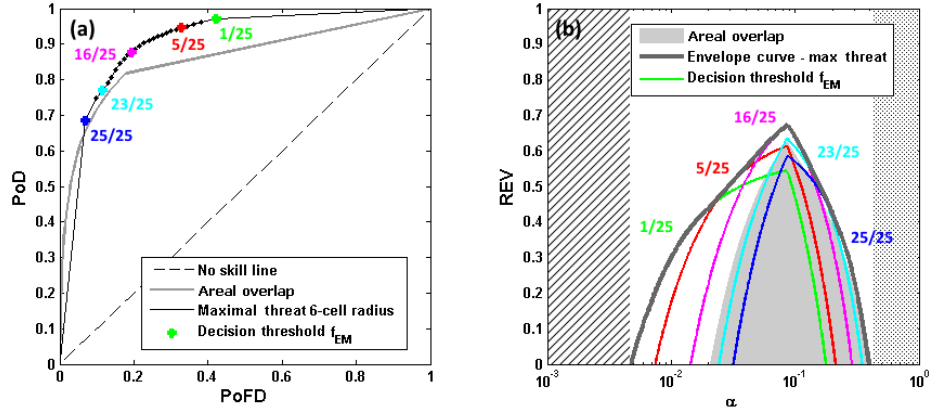
Figure 7. ROC and REV diagram for flow forecasts considering the two NWP post-processing methods: the maximal threat EPS method with a neighbourhood radius of 6 grid cells in colour and the catchment weighted areal overlap method in grey colour as background.